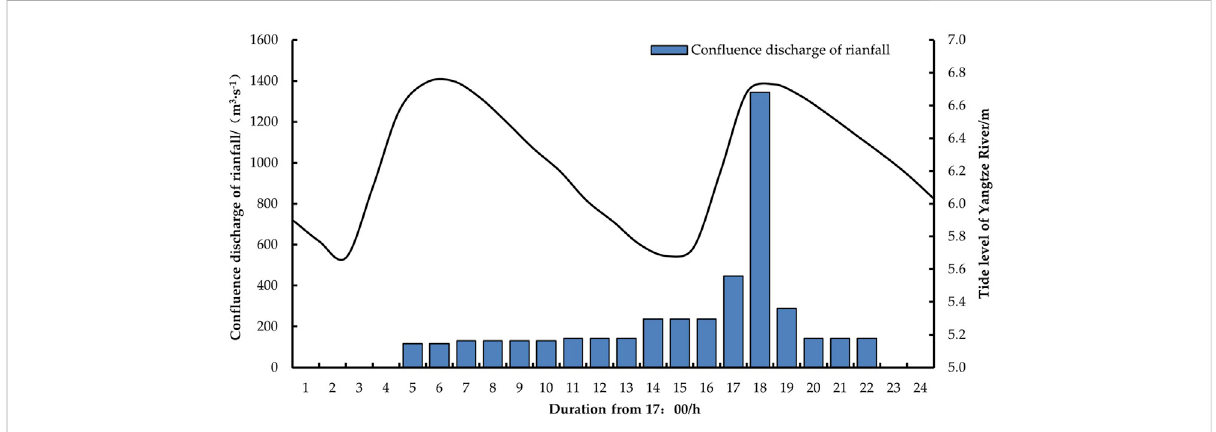
Table 1, considering the pump station should not frequently adjust the blade placement angle, the Yangtze River tide level process, the in fl uence of model accuracy, and the optimization